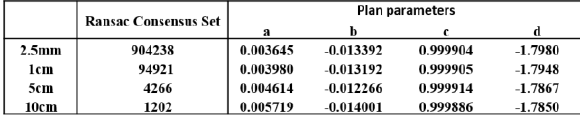
Table 4. Variation of the plane parameters at resolution